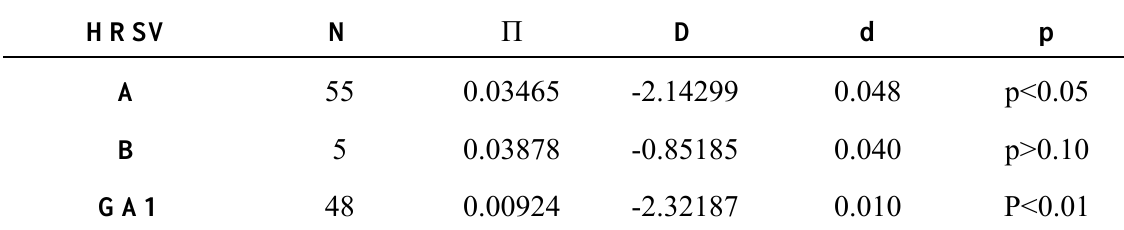
Table 1: Nucleotide diversity ( π ), Tajima D test (D), genetic distances (d) and statistical significance for Tajima D test (p) of identified human respiratory syncytial virus (HRSV) strains and GA1 genotype.